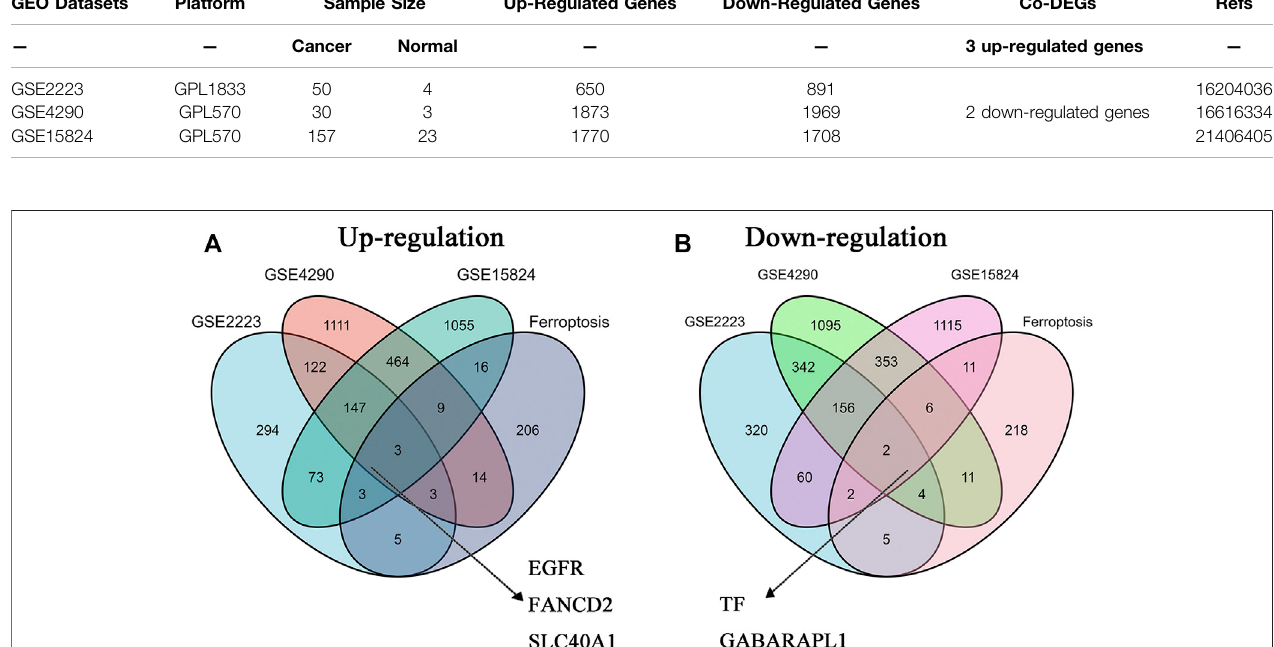
FIGURE 1 | The co-differentially expressed FRGs in three GBM datasets (A) Three up-regulated FRGs (EGFR, FANCD2, and SLC40A1) in GBM datasets (B) Two downregulated FRGs (TF and GABARAPL1) in GBM datasets.